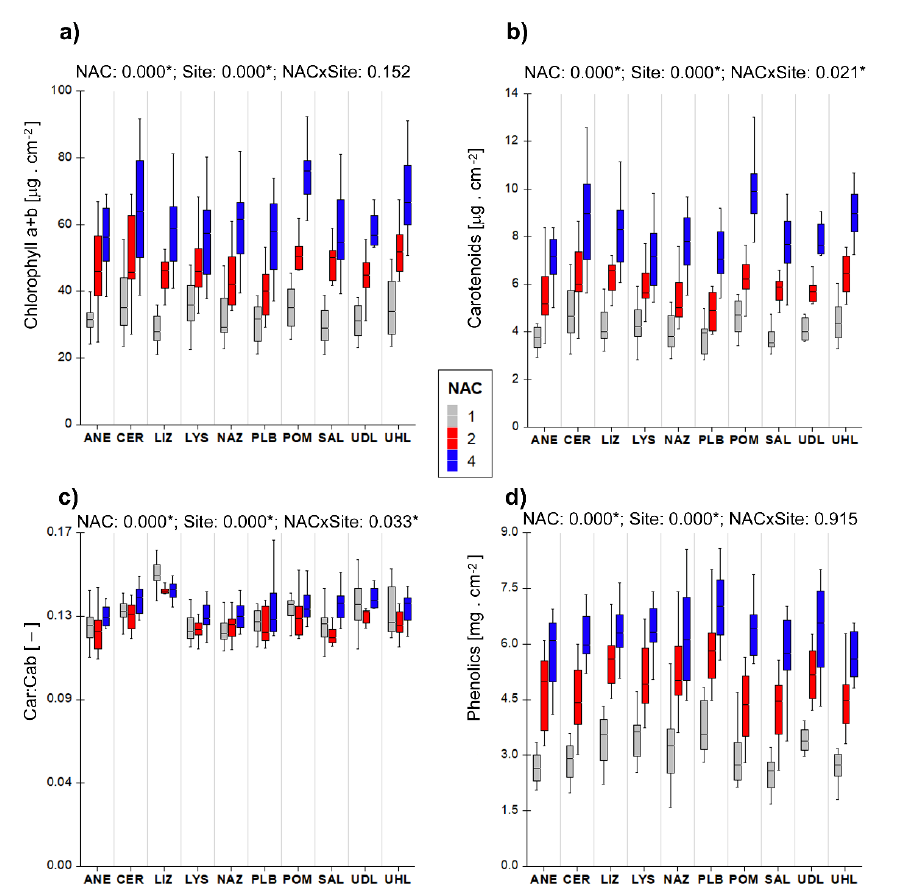
Figure 2. Needle traits according to their needle age and site location corresponding to different headwater catchments (see description in Table 1). ( a ) Chlorophyll a+b content; ( b ) total carotenoids content; ( c ) the ratio of total carotenoids to chlorophylls (Car:Cab); ( d ) soluble phenolics content in needles at ten GEOMON sites (ANE, CER, LIZ, LYS, NAZ, PLB, POM, SAL, UDL and UHL). NAC—needle age class: 1—current year needles; 2—previous year needles; 4—four year and older needles. Two-way ANOVA, effect of needle age, site, and their interaction (NAC x Site): p -values; *—significant at α = 0.05.